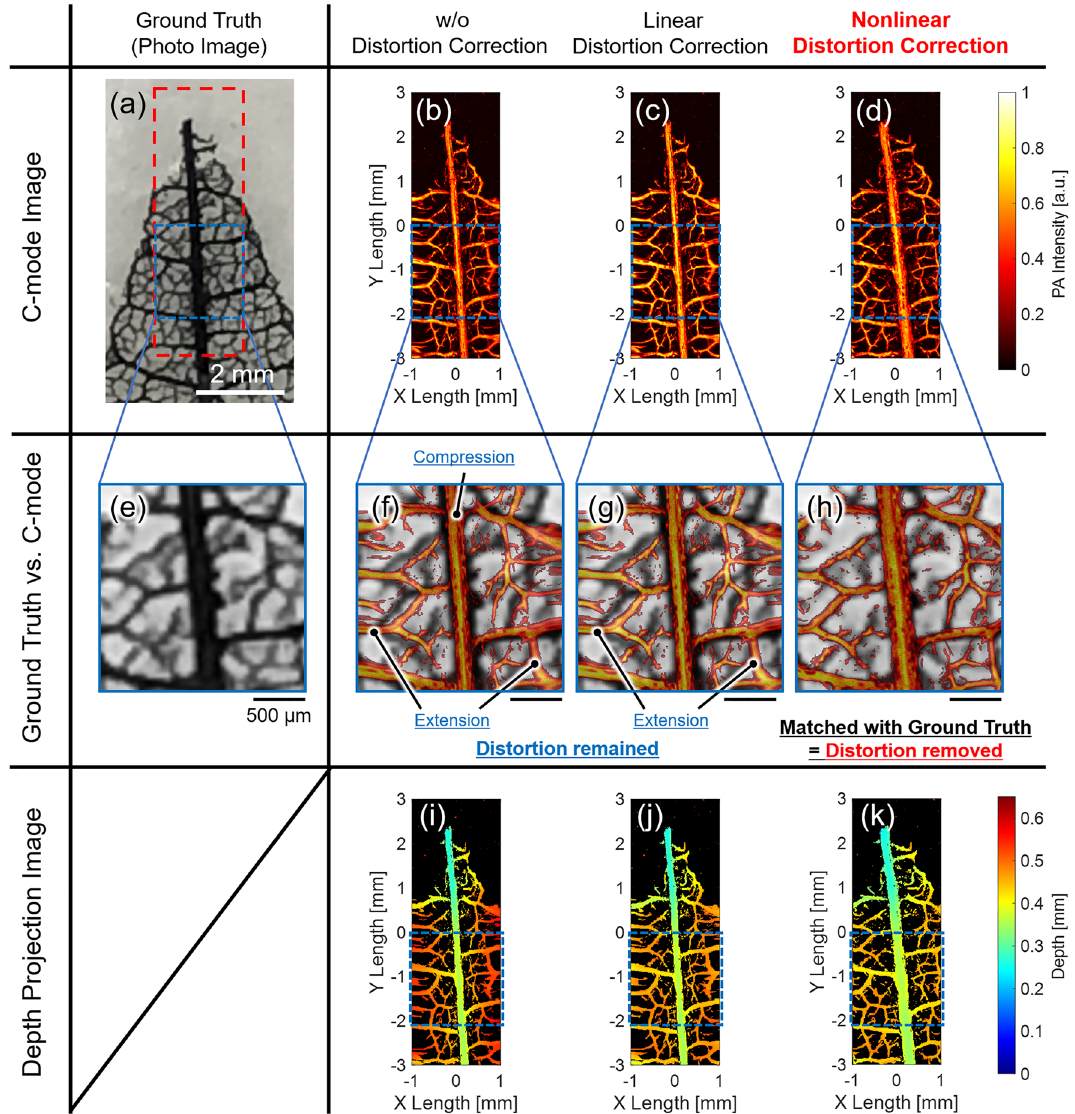
Figure 6. Results of leaf phantom PA imaging with C-mode image (Upper), enlarged image along the blue dotted square (Middle, for comparing with the ground truth), and depth projection image (Lower). ( a,e ) Ground truth (Photo image and the enlarged image). ( b,f,i ) PA images without distortion correction. ( c,g,j ) PA images with linear distortion correction. ( d,h,k ) PA images with nonlinear distortion